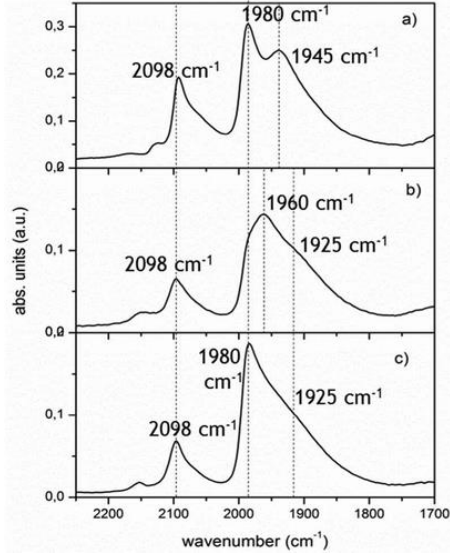
Figure 3. Diffuse reflectance infrared (DRIFT) spectra of adsorbed CO on ( a ) 5 wt.% Pd/Al 2 O 3 , ( b ) 5 wt.% Pd PVA /Al 2 O 3 and ( c ) calcined 5 wt.% Pd PVA /Al 2 O 3 . Reprinted with permission from ref. [38]. Copyright 2016, with permission from American Chemical Society.